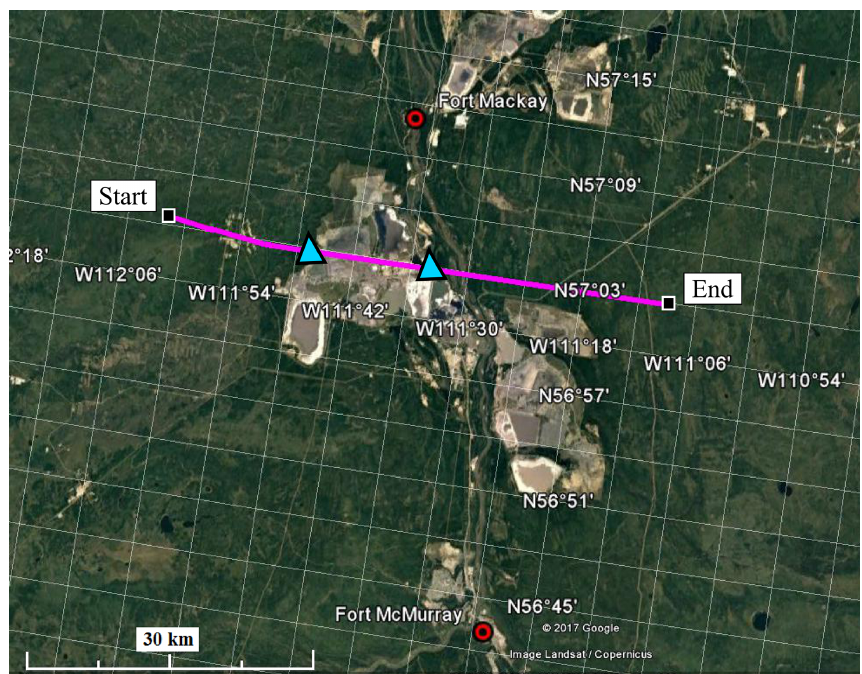
Figure 17. A section of the Convair flight on 23 August 2013 is shown in pink. In situ measurements were collected from west to east between 11:27 and 11:37 local time (UTC − 6h) on 23 August 2013. The triangular marks indicate the positions of the dashed lines in Fig. 18.